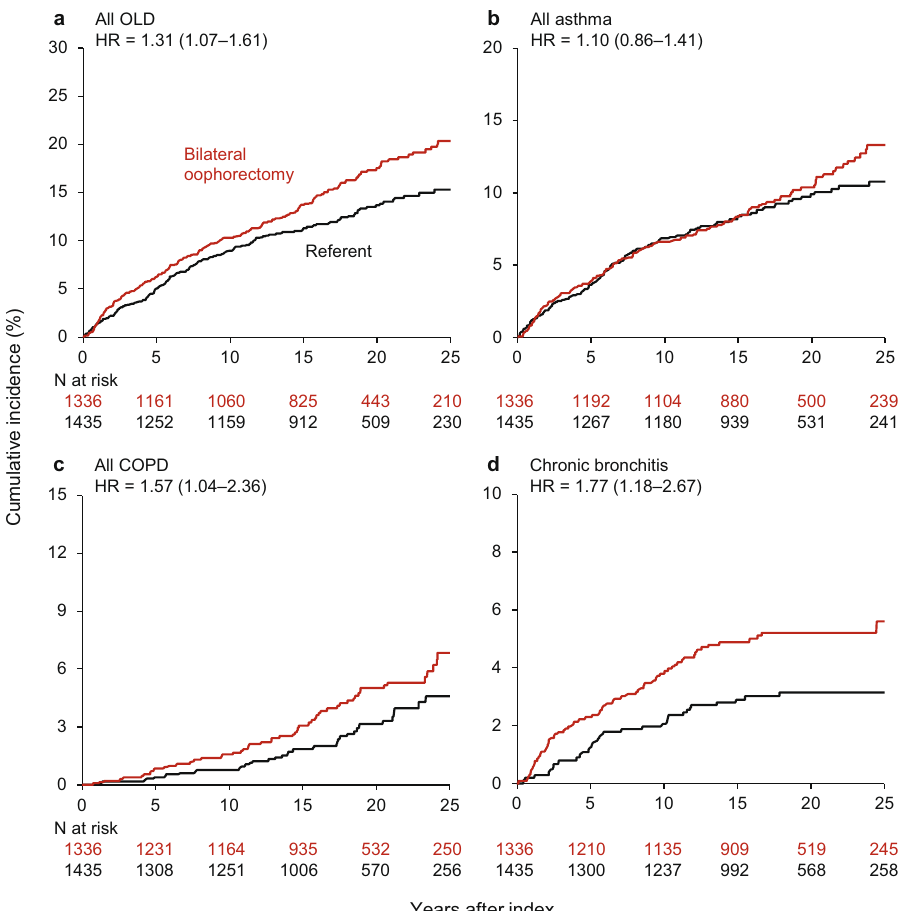
Fig. 1 Cumulative incidence curves for obstructive lung disease, in all women who underwent bilateral oophorectomy compared with all referent women. a All OLD; b , all asthma; c , all COPD; d , chronic bronchitis. The curves were weighted using inverse probability weights derived from a logistic regression model including 16 chronic conditions present at index, years of education, quartiles of household income, race, body mass index, cigarette smoking, and age and calendar year at index date (details provided in text). COPD chronic obstructive pulmonary disease, HR hazard ratio, OLD obstructive lung